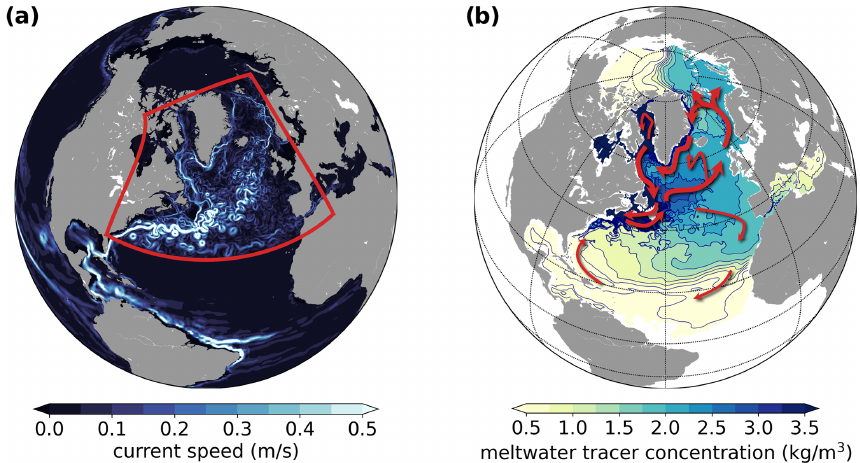
Figure 1. (a) Snapshot (5d mean) of upper-ocean current speed at about 100m depth, exemplifying the impact of the grid refinement. The area covered by the two-way nested model VIKING10, in which the grid is refined from 1 / 2 to 1 / 10 ◦ , is marked by the red frame. (b) Concentration of the passive tracer tagging the freshwater perturbation (enhanced Greenland runoff) at the end of the experiment after 100 years (same 5d mean, also at 100m depth). Red arrows sketch the main pathways of the freshwater added. Table 1. Overview of numerical experiments: coupled experiments apply the ECHAM6 atmosphere model, forced ones use CORE-II at- mosphere reanalysis. In the 1 / 2 ◦ global ocean model, eddies are parameterized using GM (Gent and McWilliams, 1990), whereas in the North Atlantic nest with a grid resolution of 1 / 10 ◦ , mesoscale eddies are simulated explicitly instead. A freshwater flux (FWF) of 0.05Sv is added as seasonally varying runoff using a spatially heterogeneous but time-invariant pattern along Greenland’s coasts in the perturbation experiments. See main text for